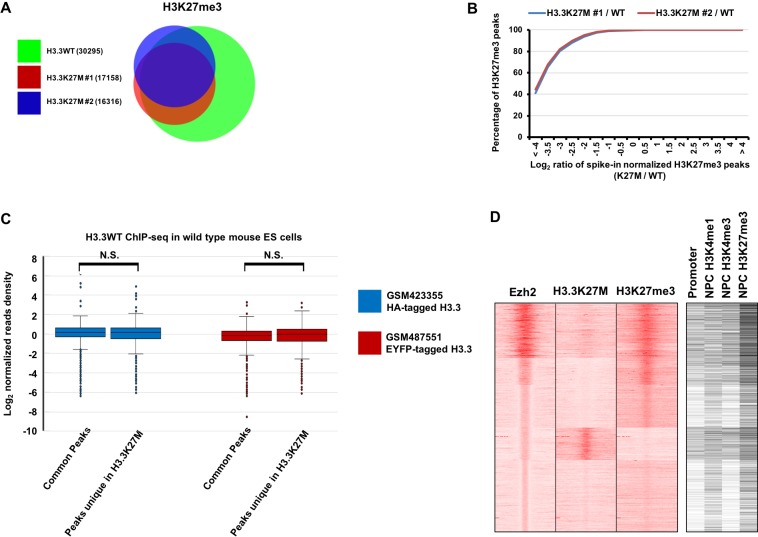
A large number of Ezh2 peaks uniques in H3.3K27M mutant mouse ES cells is identified.(A) Venn diagram illustration of H3K27me3 peaks in the wild type (WT) and two H3.3K27M mutant mouse ES clones and their overlap. The number of peaks identified in each cell line was shown in the key. (B) Compared to WT mouse ES cells, H3K27me3 levels at all peaks in H3.3K27M mutant ES cells were reduced. H3K27me3 ChIP-seq was performed in WT and two H3.3K27M mutant clones spiked-in with chromatin from Drosophila. H3K27me3 peaks were identified and cumulative distribution analysis of the Log2 ratio of H3K27me3 levels between mutant and WT cells (K27M/WT) was shown (X-axis). The percentage of H3K27me3 peaks at each ratio was shown at the Y-axis. Note that the percentage of H3K27me3 peaks reaches 100 with a Log2 ratio of H3K27me3 levels (K27M/WT) less than 0, which indicates the levels of H3K27me3 at all H3K27me3 peaks identified in H3.3K27M mutant ES cells are reduced compared to WT mouse ES cells. (C) Boxplot showing that the enrichments of wild type H3.3 proteins at common Ezh2 peaks found in both WT and H3.3K27M mutant cells are similar to those at Ezh2 peaks unique to H3.3K27M mutant cells. The HA- and EYFP-tagged H3.3 ChIP-seq results were downloaded from GSM423355 and GSM487551, respectively and used for the analysis. P value was calculated by two-tailed Student’s t test. (D) Heatmap of the clustered Ezh2 peaks from Piunti et al. (Piunti et al., 2017) shows their corresponding H3.3K27M and H3K27me3 ChIP-seq signals in SF8628 cells. The analysis was performed as described in Figure 2H and the histone ChIP-seq datasets in NPC are from ENCODE (https://www.encodeproject.org/). The enrichment of H3.3K27M and H3K27me3 could be seen in some groups of genes, which is not seen in Figure 2H. This difference may be due, in part, to the fact that different antibodies were used in these two studies.